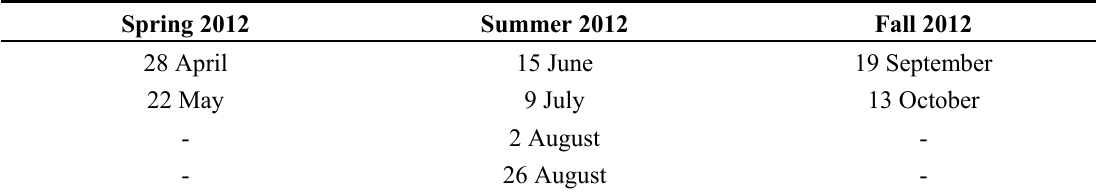
Table 1. RADARSAT-2 images acquired over Peace-Athabasca Delta (Lake Claire) for 2012. Note, all RADARSAT-2 images were Single Look Complex (magnitude only used to extract surface water), had an incidence angle of 29.5°–33.0°, a 1.6 × 2.8 m 2 spatial resolution, HH polarization, and a swath width of 50